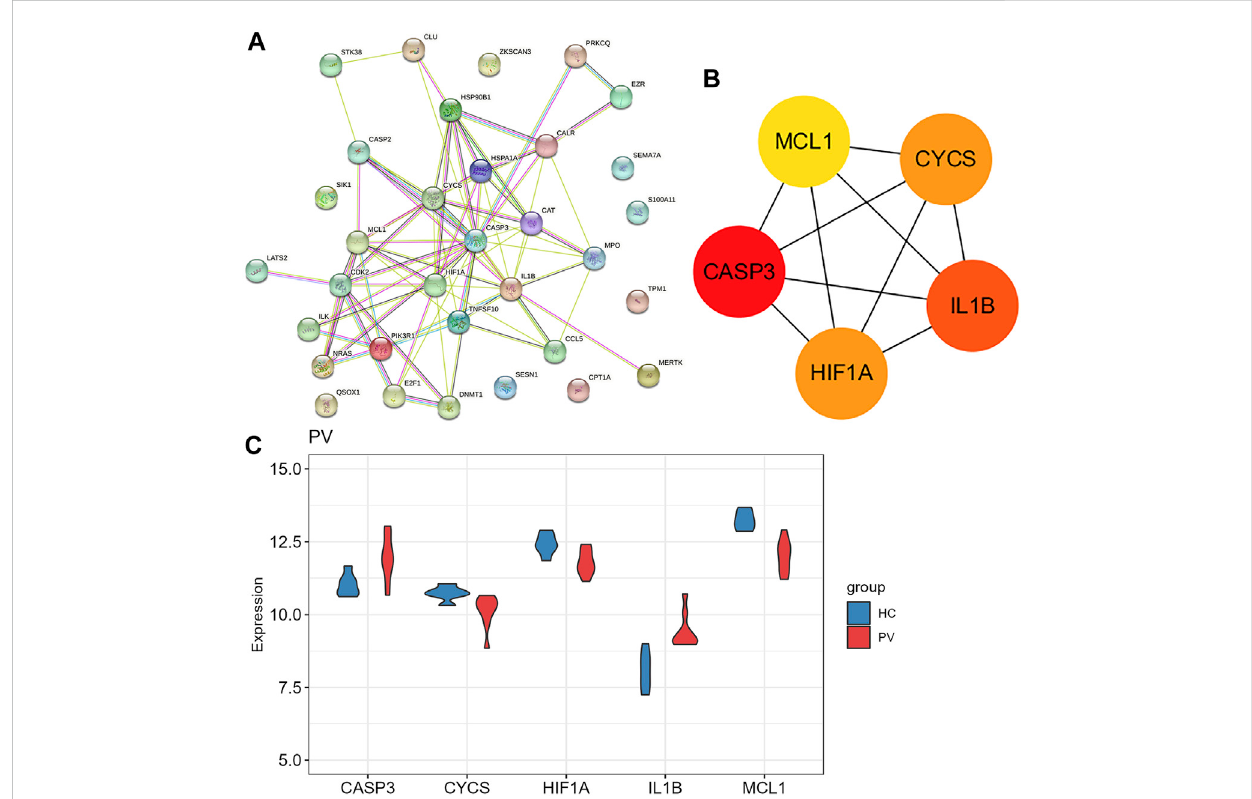
FIGURE 6 Theprotein-proteininteractionnetwork ofanoikis-relatedDEGsinPolycythemiaVera. (A) PPInetwork for36anoikis-relatedDEGs; (B) Subnetwork of hub genes from the PPI network. Node color re fl ects the degree of connectivity (red color represents a higher degree, and yellow color represents a lower degree). (C) The expression difference of fi ve hub genes in the training set (GSE136335).